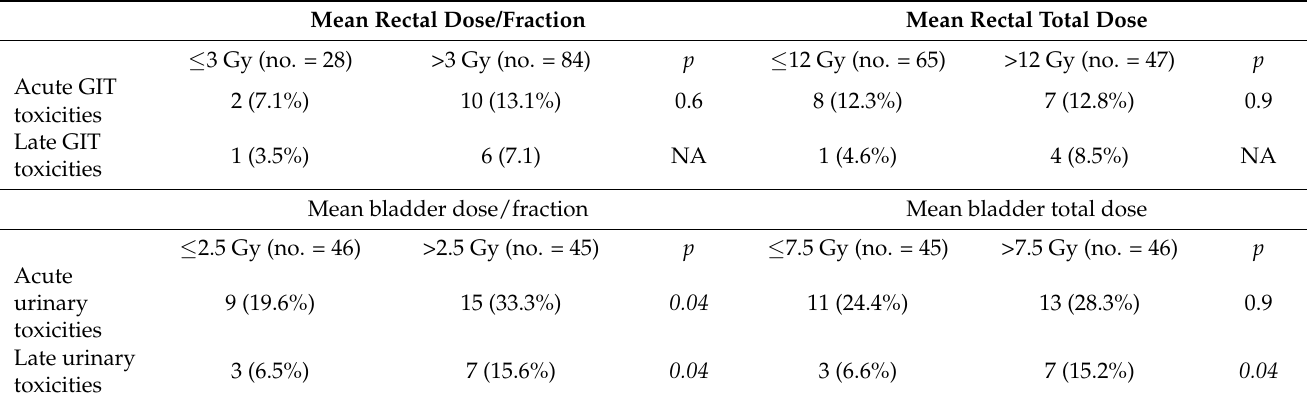
Table 5. Rectal and bladder doses in relation to GIT and urinary